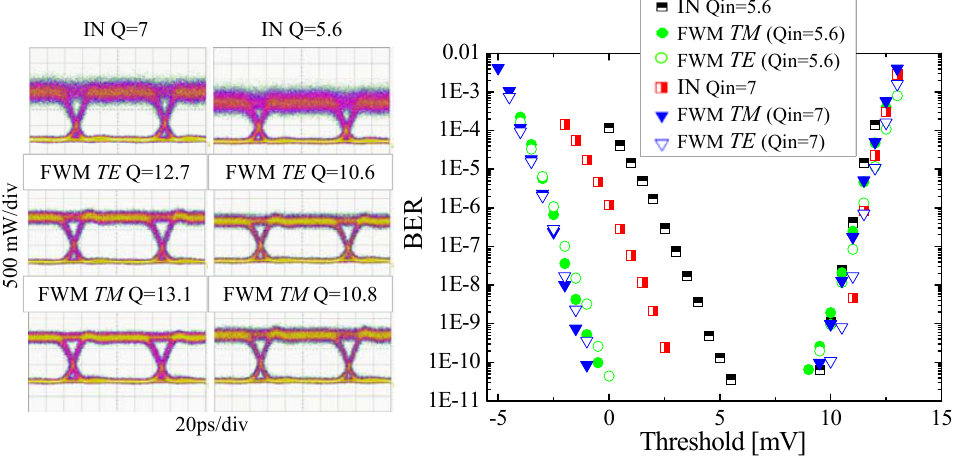
(FWM) when input is polarized TE (FWM TE ), and FWM when input is polarized TM (FWM TM ) signals; ( right ) BER vs. voltage threshold measurements for the input (IN), FWM when input is polarized TE (FWM TE ), and FWM when input is polarized TM (FWM TM ) signals. Pumps detuning is fixed at 2 nm; λ = 1558 λ P2